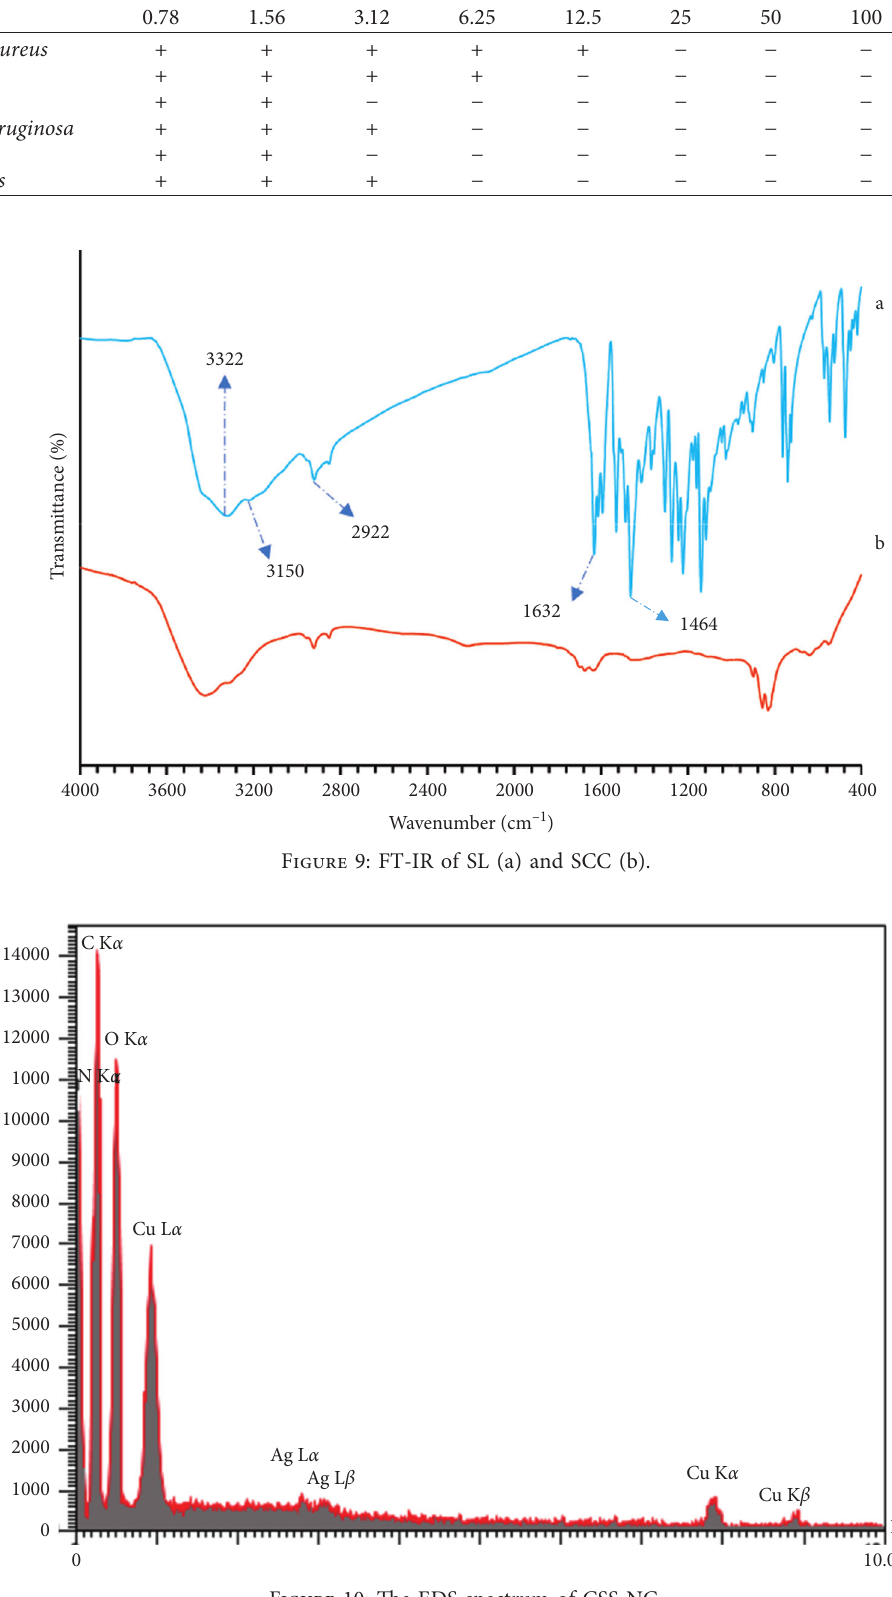
Figure 10: The EDS spectrum of CSS NC.